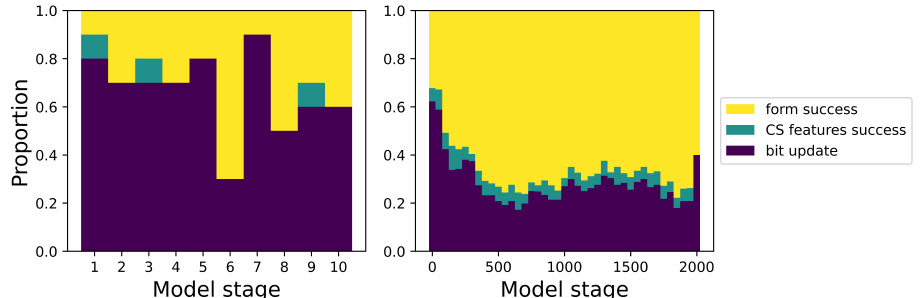
Figure 8. The proportion of language game results (form success, culturally salient features success or bit update) for a model run with 10 agents randomly assigned to 1 of 10 groups ( n_groups = 10) for the first 10 model stages ( left ) and over the 2000 stages ( right ). At each stage, 10 language games were played. The x-axis starts at stage one because in stage zero there is only model set up and no language game. The majority of the language games at the start of the simulation end with bit update, while later, more end with form success and still a considerable amount end with bit update. Few language games end with culturally salient features success (here abbreviated as CS features success). Over 2000 stages, shown on the right, the results were averaged over 50 consecutive model stages (i.e., each bar of the histogram represents the mean of 50